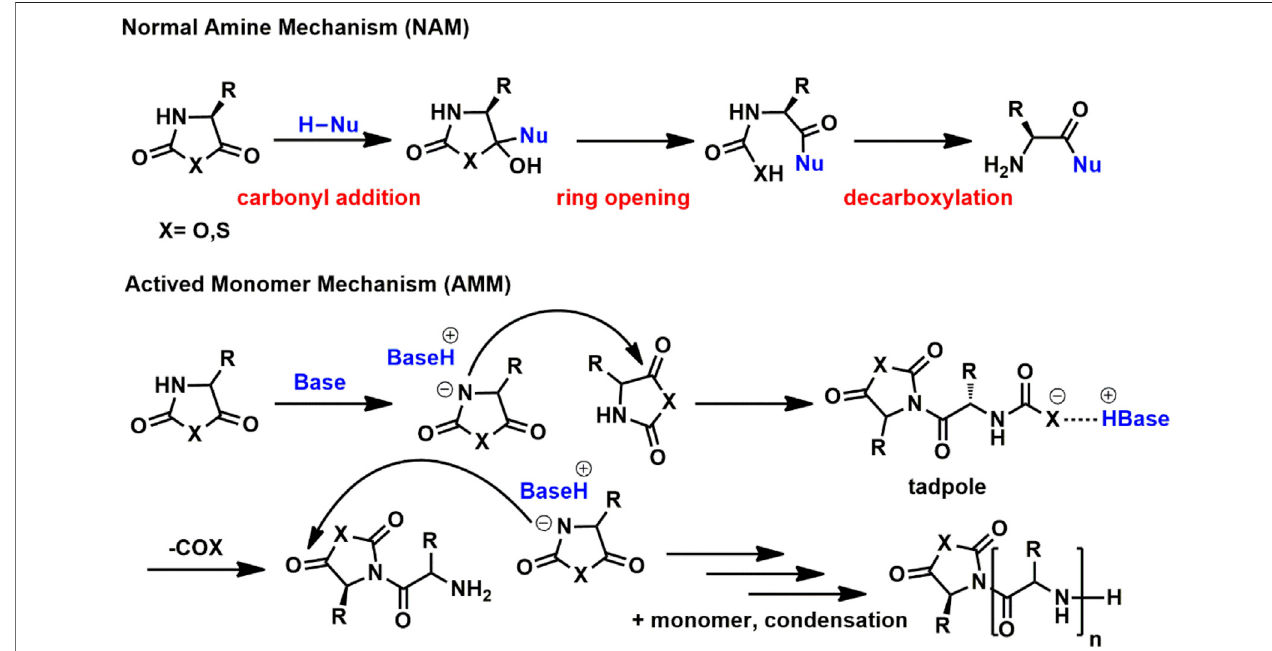
SCHEME 1 | NAM and AMM mechanisms for the ring opening polymerization of cyclic monomers toward poly( α -amino